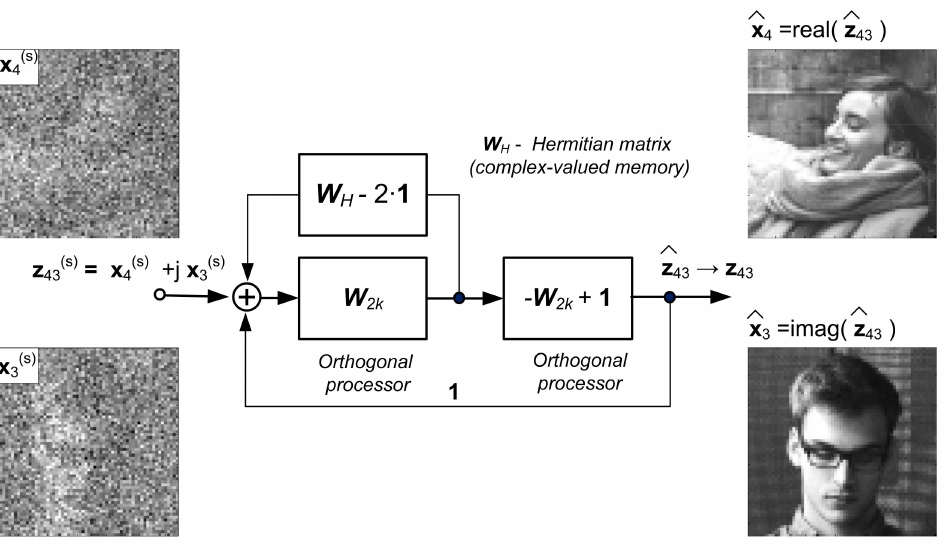
Figure 18. Complex-valued image reconstruction: z 43 = x 4 + j x 3 , j 2 = − 1, x 3 , x 4 —vectorized form of images No. 3 and No. 4 in Figure 3, x